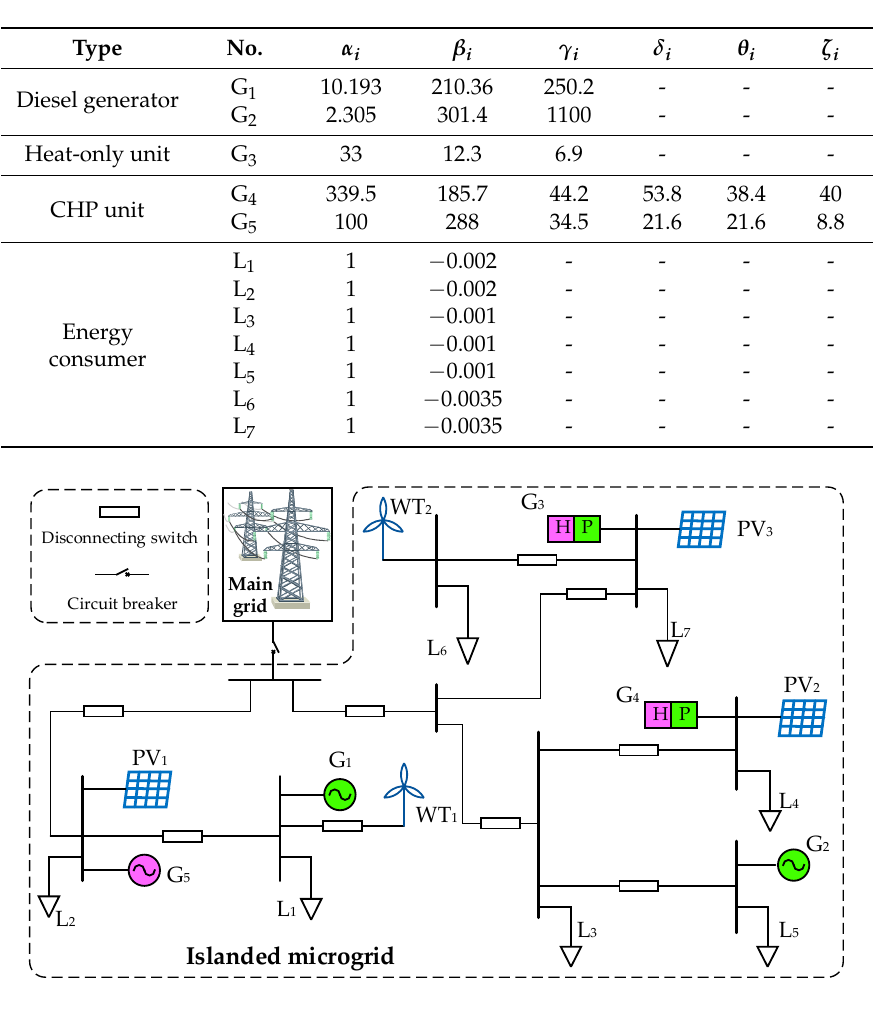
Table 2. Operating cost coefficients of controllable units.